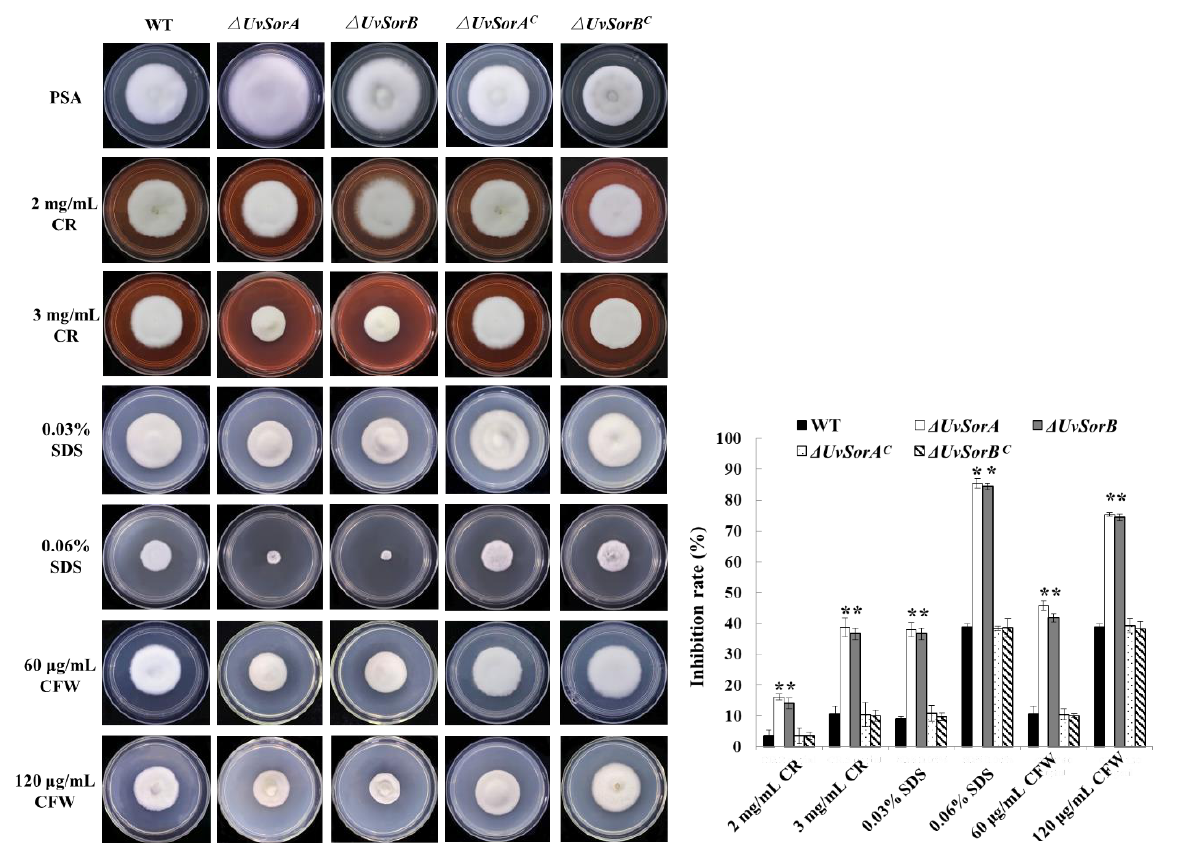
Figure 12. UvSorA and UvSorB contributed to the tolerance to cell wall damaging agents. The colony of tested strains under the stresses of cell wall damaging agents grown at 28 °C for 18 days (left panel). Statistical analysis of mycelial growth inhibition rate under cell wall stresses (right panel). Three independent biological experiments were performed with three replicates each time. Error bars represent the standard deviation, and the asterisk (*) represents a significant difference at p < 0.05, ** p < 0.01.